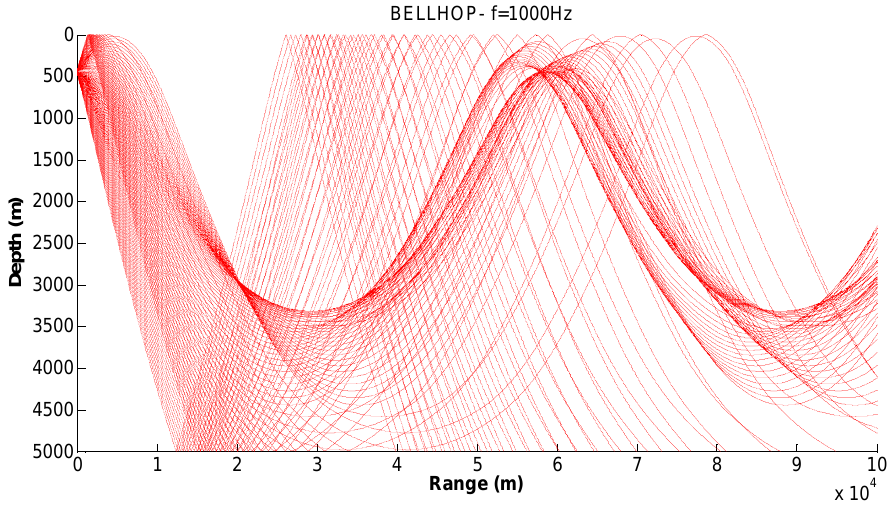
Figure 10. Corresponding ray trace for a source depth of 450 m.